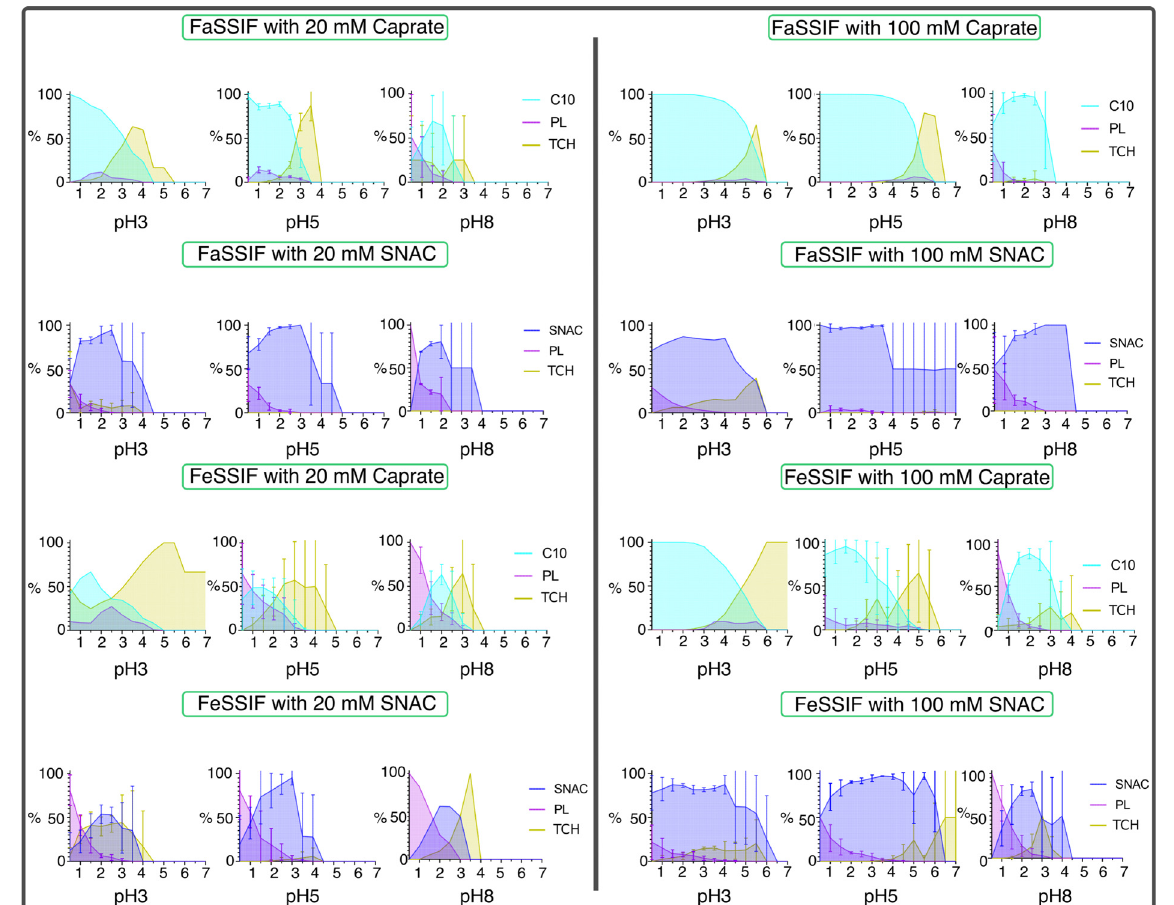
Figure 7. Density of molecule-specific beads at distances from aggregate core. Error bars display the standard deviation in systems with multiple aggregates. Abbreviations: caprate (C10), phospholip- ids (PL), taurocholate (TCH), sodium N-(8-[2-hydroxybenzo]amino caprylate